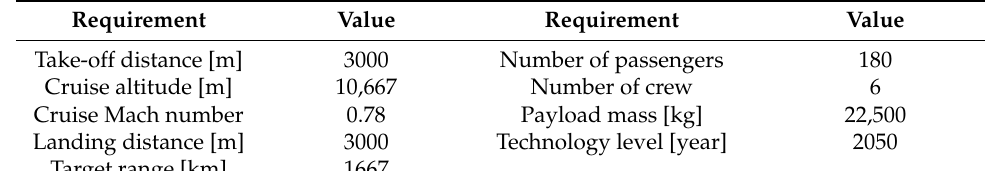
Table 4. Mission requirements of the baseline design.